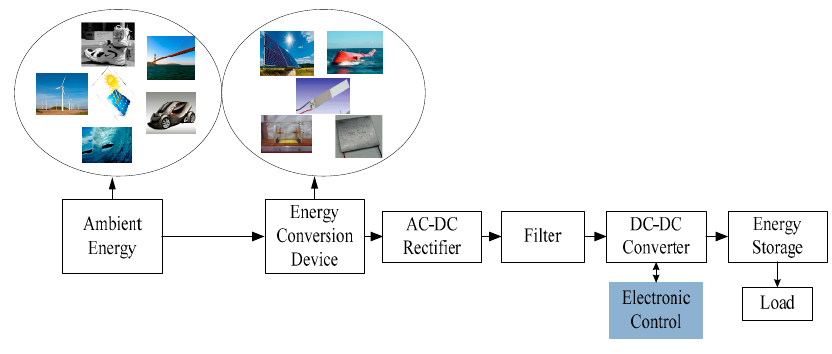
Figure 1. Block diagram of vibration energy harvesting system.